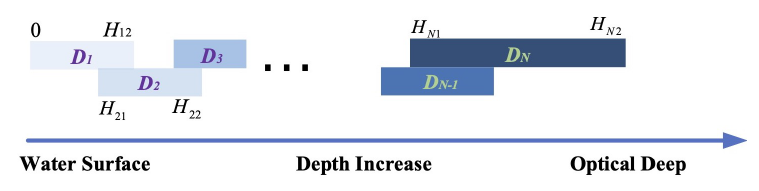
Figure 10. Description of the depth interval division.